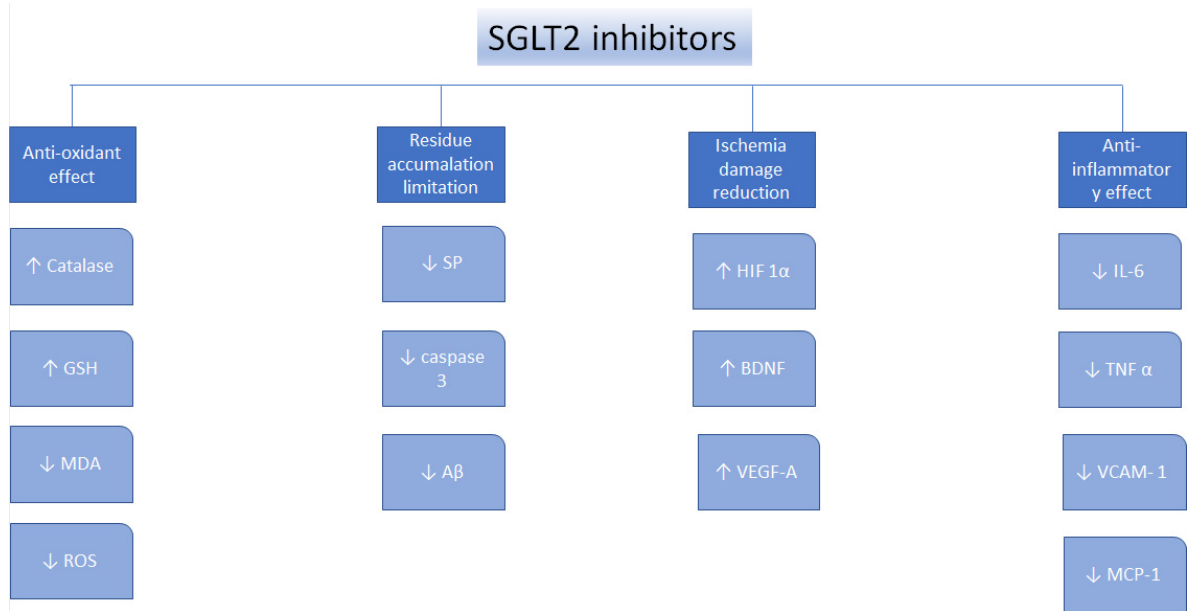
Figure 1. Mechanisms of action for the SGLT2 inhibitors. ↑ —increase, ↓ —decrease, glutathione- GSH, malondialdehyde -MDA, senile plaques -SP, amyloid β -A β , hypoxia-inducible factor 1 α - HIF1 α , brain-derived neurotrophic factor -BDNF, vascular endothelial growth factor A -VEGF-A, interleukin 6-IL-6, tumor necrosis factor α -TNF α , vascular cell adhesion protein -VCAM-1, reactive oxygen species -ROS, monocyte chemotactic protein-1-MCP-1.[75].